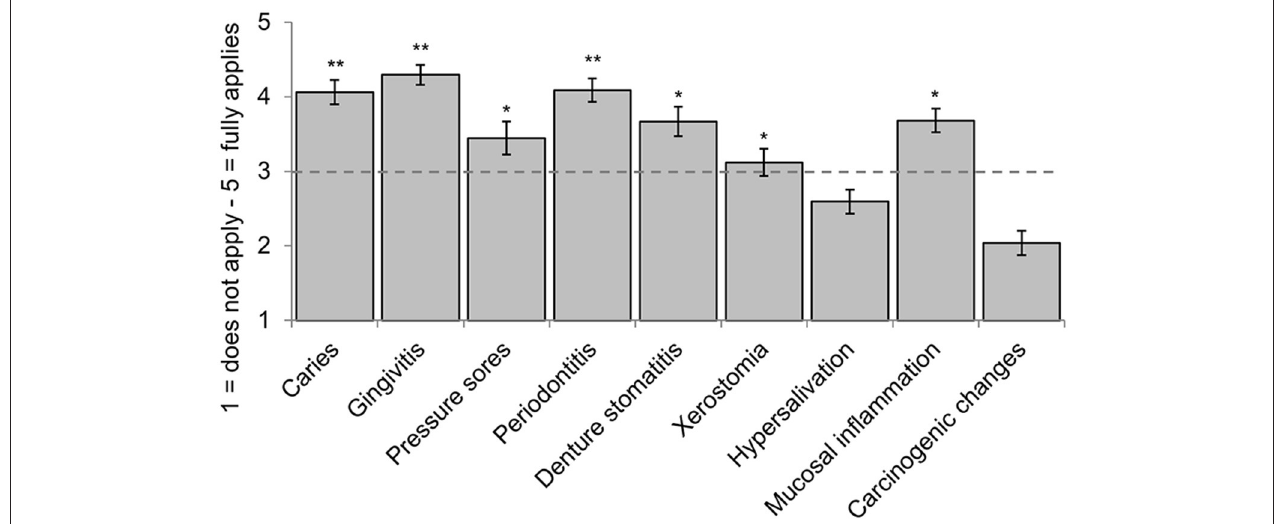
FIGURE 3 | Estimated intraoral diseases in patients with dementia (means, 95%-CIs). Caries, gingivitis, pressure sores, periodontitis, denture stomatitis, xerostomia, hypersalivation, oral mucosal inflammation, carcinogenic changes; *exceeds expression 3 = “undecided”; **exceeds expression 4 = “somewhat agree,” n =